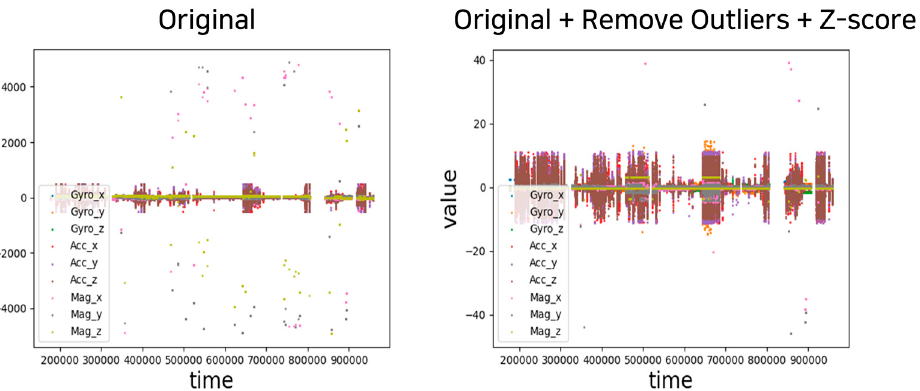
Figure 9. Comparison graph before and after sensor data preprocessing.